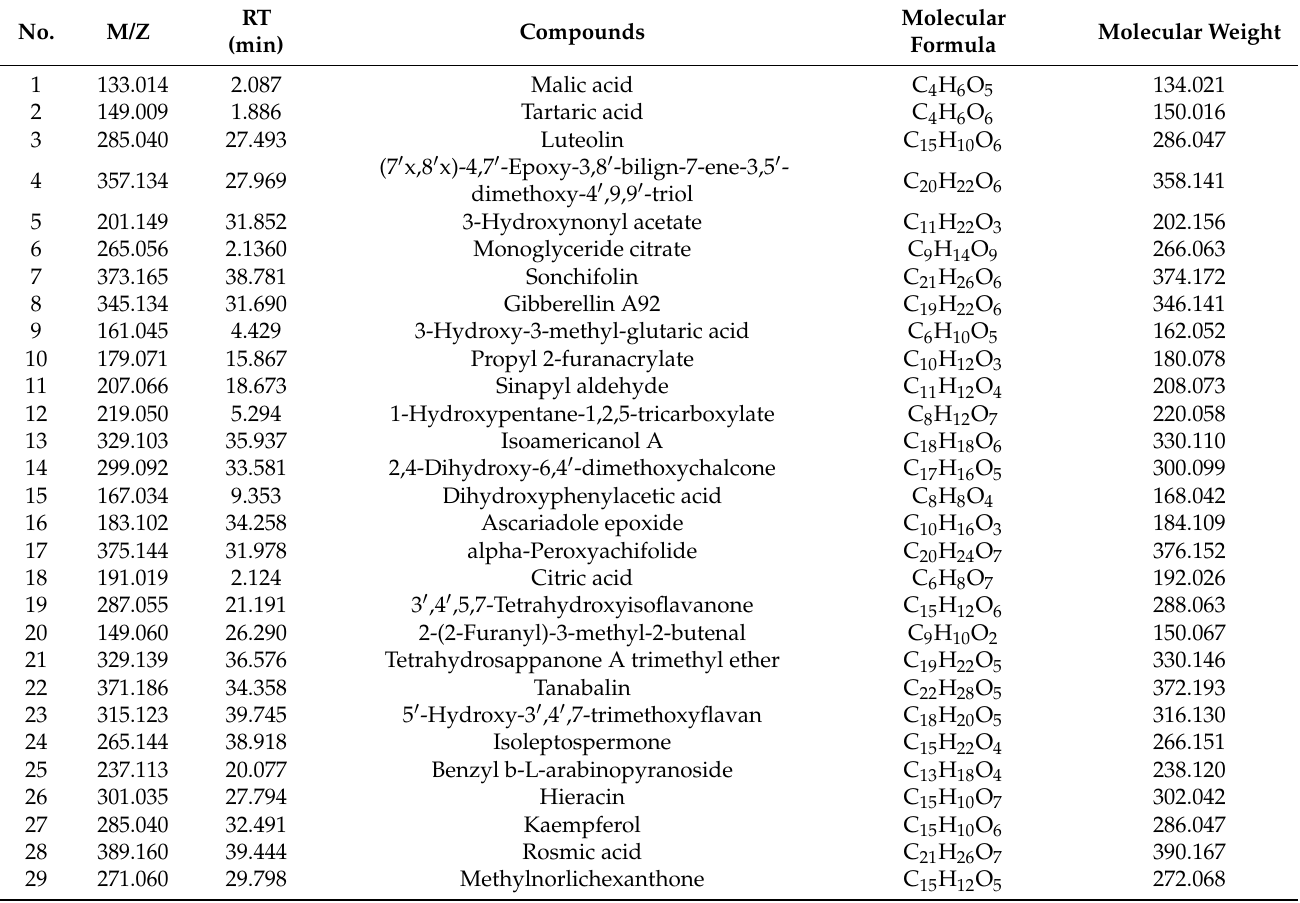
Table 2. Compounds identified in the ethanolic M. fragrans extract by